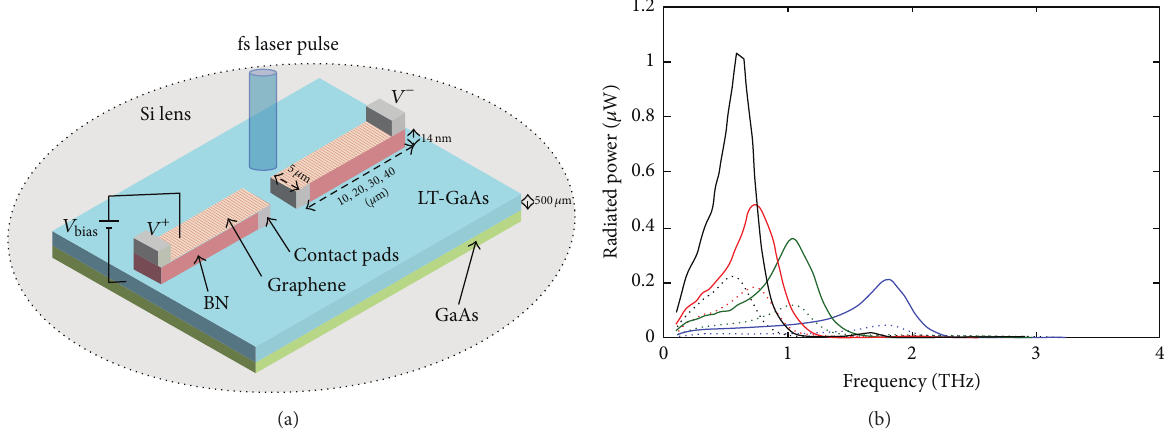
Figure 7: (a) Structure of graphene RF plasmonic antenna fed with a photoconductive material. (b) Radiated power with respect to frequency for graphene antennas with lengths 10 𝜇 m (blue), 20 𝜇 m (green), 30 𝜇 m (red), and 40 𝜇 m (black)